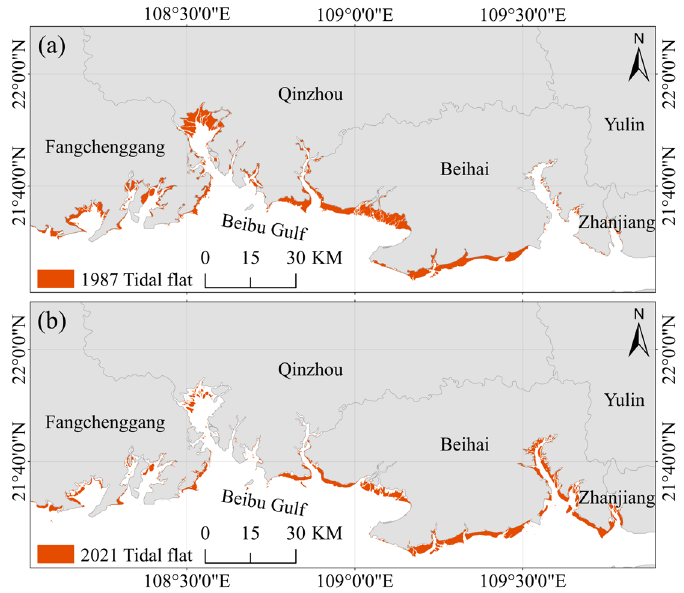
Figure 10. Distribution of tidal fl ats in Beibu Gulf in 1987 and 2021. (a) Distribution of tidal fl ats in Beibu Gulf in 1987. (b) Distribution of tidal fl ats in Beibu Gulf in 2021.